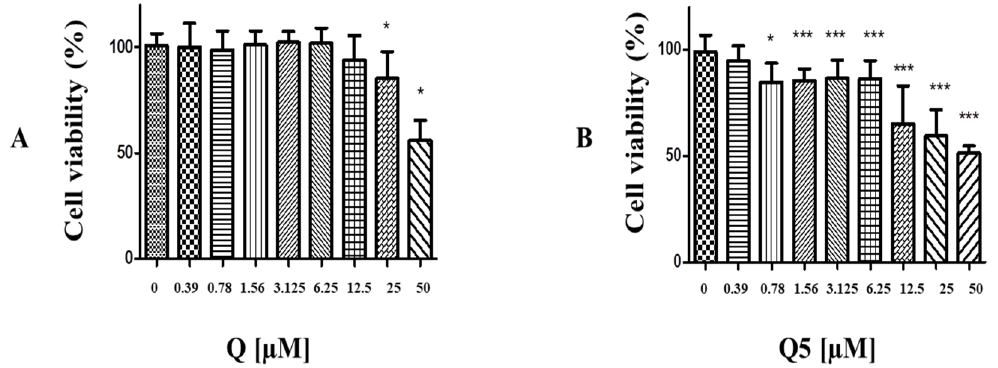
Figure 4. Analysis of cytotoxic activity by MTT test in C6 cells exposed to Q and Q5 compound at concentrations of 50 µ M and 7 1:2 dilutions. ( A ) C6 after 72 h of exposure to quercetin. ( B ) C6 after 72 h of exposure to quercetin pentaacetate (Q5). Cells under control conditions were treated with 0.05% DMSO—a vehicle for drug dilution. The results expressed as a percentage in relation to the control, taken as 100% (* p < 0.05; *** p < 0.001). The different patterns of the column chart represent different concentrations of quercetin (Q) in A, and quercetin pentaacetate (Q5) in B.